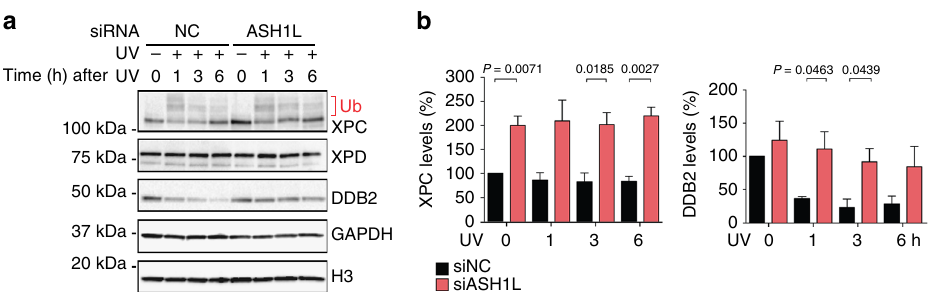
Fig. 4 Increased XPC expression upon ASH1L depletion. a Immunoblot analysis of XPC, XPD and DDB2 in whole cell lysates. HeLa cells were pre-treated with siRNA targeting ASH1L or non-coding control RNA (NC), UV-irradiated (10 J m – 2 ) 48 h later and collected at different times. GAPDH and H3 were used as loading controls. b Level of XPC and DDB2 normalized to H3 ( n = 4 independent experiments). Quanti fi cations include both unmodi fi ed and ubiquitinated XPC. Protein levels in unirradiated controls are set to 100% and error bars show s.e.m. (one-sample